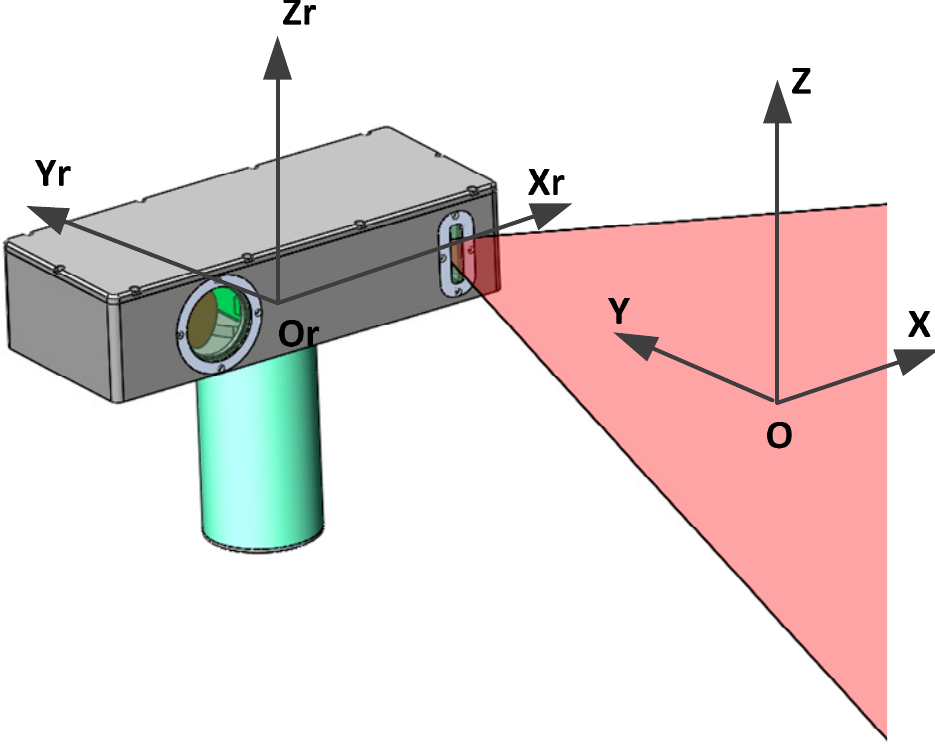
Figure 1. The self-rotating, linear-structured light scanning measurement system. Alismail et al. [14] proposed an algorithm to automatically calibrate the rotation center for the problem that the 2D LIDAR rotation center and the driving device center may not overlap, and this method does not require a special target and can be used in general measurement scenarios. This method is based on the assumption that the surface in the local neighborhood of the 2D LIDAR point cloud can be well approximated to a plane. Since the full scan is symmetrical, the full scan is divided into two half scans of the same object, and the distance from the plane to the center in the range of the corresponding angle laser point is equal, and the transformation matrix that minimizes the dissimilarity of the two data is calculated so that the calibration of the center of rotation is completed. This method does not require special calibration objects, but the algorithm is more complicated. Huang Fengshan et al. [15] used a rectangular parallelepiped with a triangular prism in the middle channel as the calibration piece to complete the calibration. The calibration piece is large and requires special customization. Cai et al. [16] proposed using a special